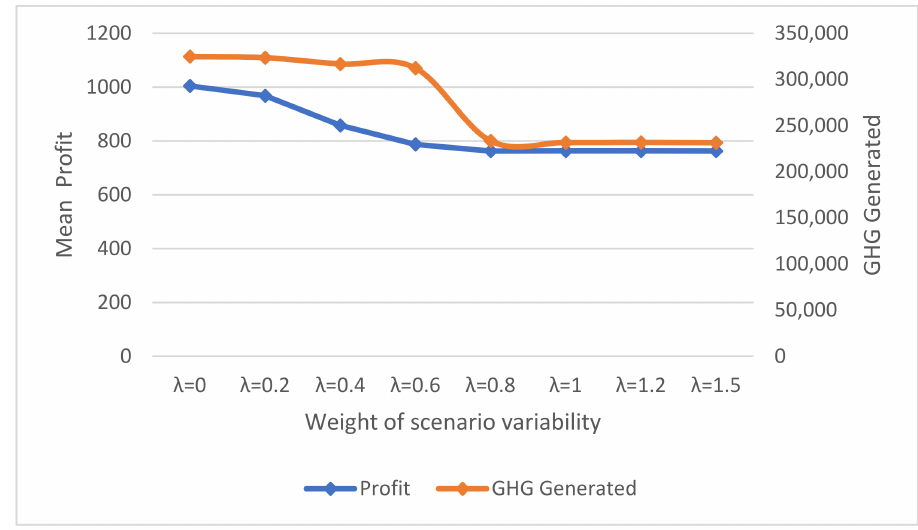
Figure 5. Value of objective functions for different value of λ .